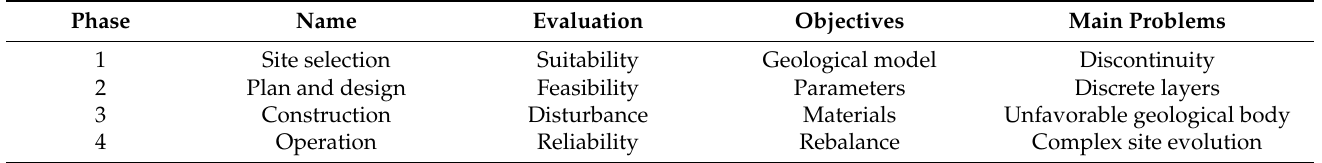
Table 2. Timeline for engineering site selection of the